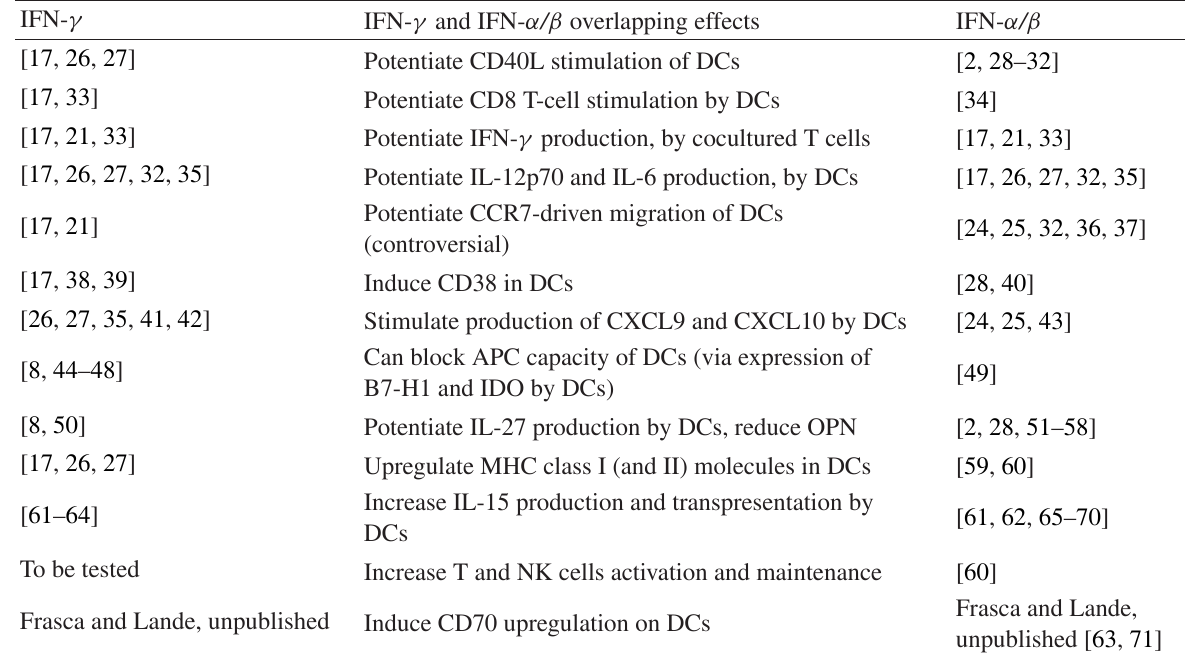
TABLE 1: Type II and I IFN overlapping effects on dendritic cells. The scheme depicted resumes the most important overlapping effects of type II and I IFNs on DCs. Numbers refer to references as reported in the References section.